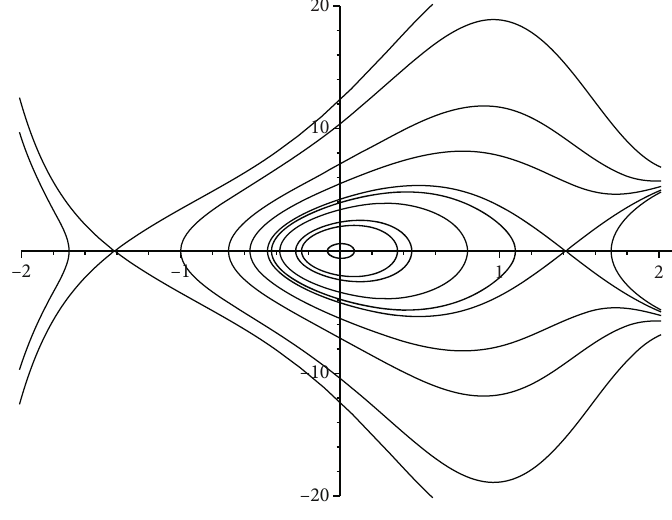
Figure 12: The phase portrait of x ′′ + μ ð x 2 − 1 Þ x ′ 2 + ax − bx 3 = 0 , a = 50 , b = 25 , μ = 1